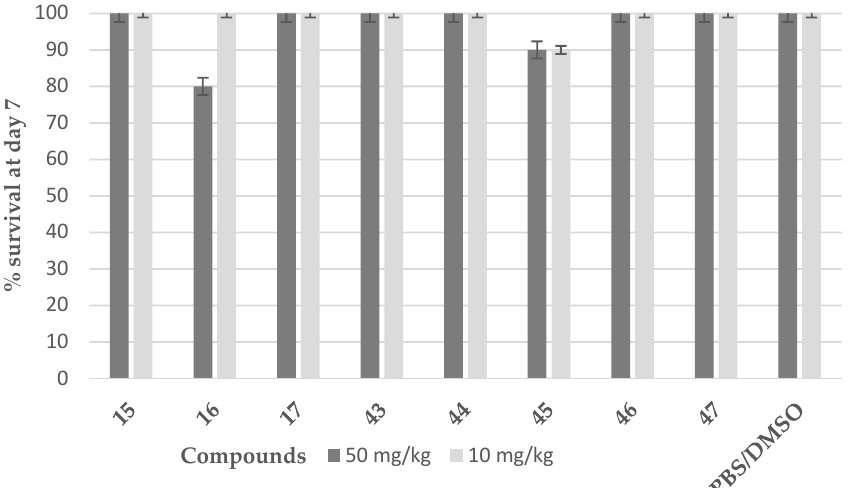
Figure 4. Evaluation of the in vivo cytotoxicity of dibenzofuran derivatives 15 – 17 and 43 – 47 on the G. mellonella model. Percentage of survival 7 days after injection of doses of 10 and 50 mg/kg for each compound. Mean of two independent experiments.